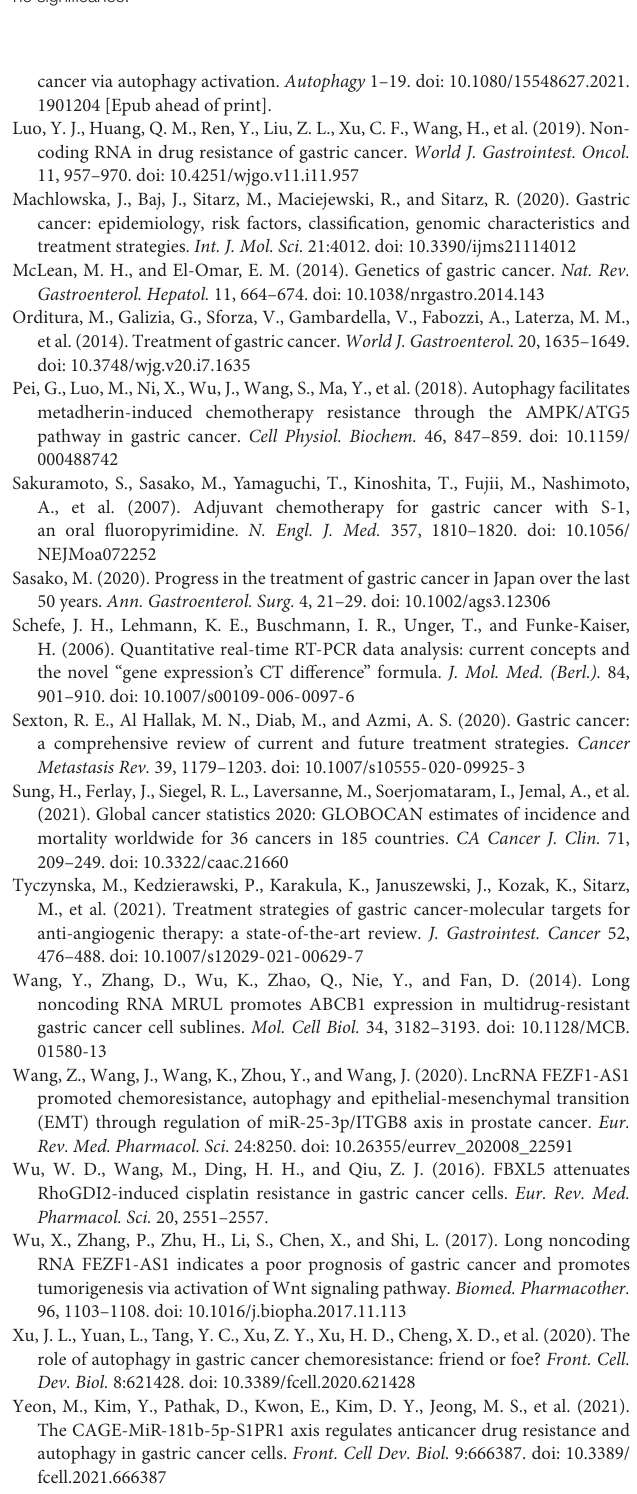
Supplementary Figure 1 | Effect of disruption of FEZF1-AS1 on cell cycle related genes and ATG5 mRNA levels. qRT-PCR detected the mRNA levels of cell cycle related genes (p21 and cyclin D1) and ATG5 in overexpressed (A) or knockdown (B) FEZF1-AS1 in SGC7901 cells. The results represented the mean ± SD of 3 independent experiments. ∗ P < 0.05, ∗∗ P < 0.01, ∗∗∗ P < 0.001,